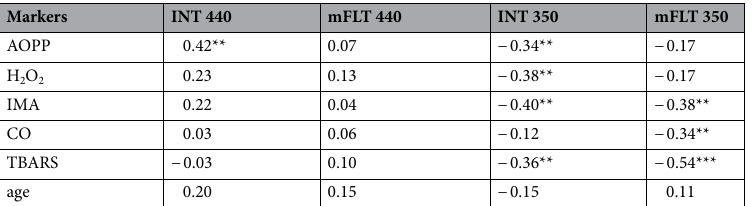
Table 2. Correlations between fluorescence parameters of plasma and approved markers and age. Fluorescence parameters: intensity at 440 nm (INT 440), mean fluorescence lifetime at 440 nm (mFLT 440),